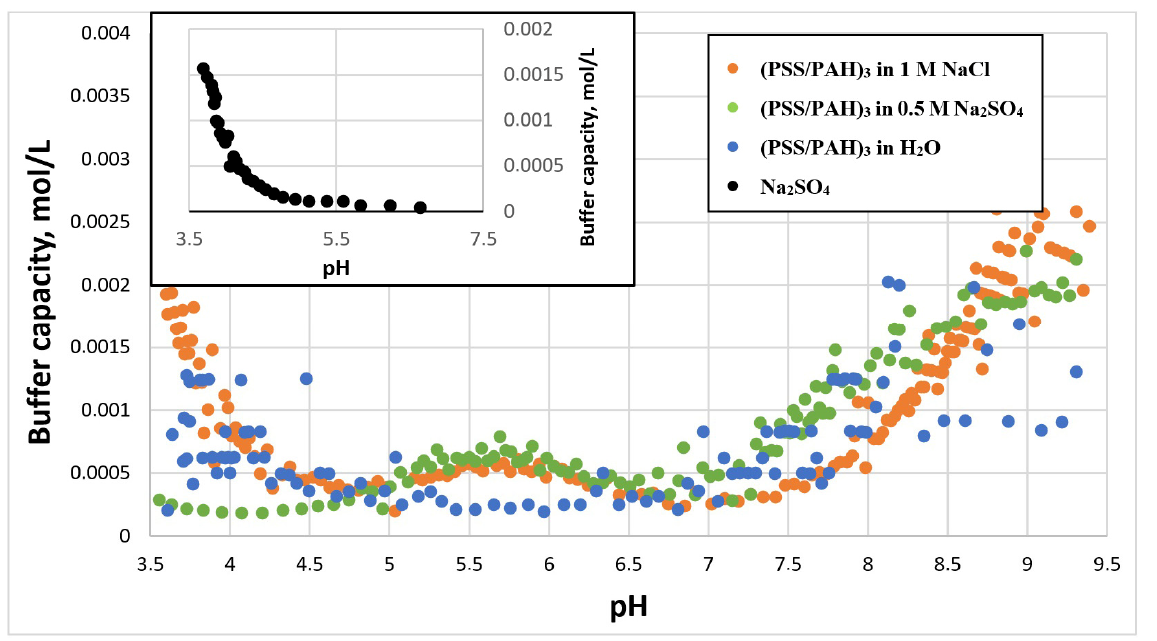
Figure 1. Buffer capacity of PMC composition (PSS/PAH) 3 at different pH in water, 1 M NaCl and 0.5 M Na 2 SO 4 .